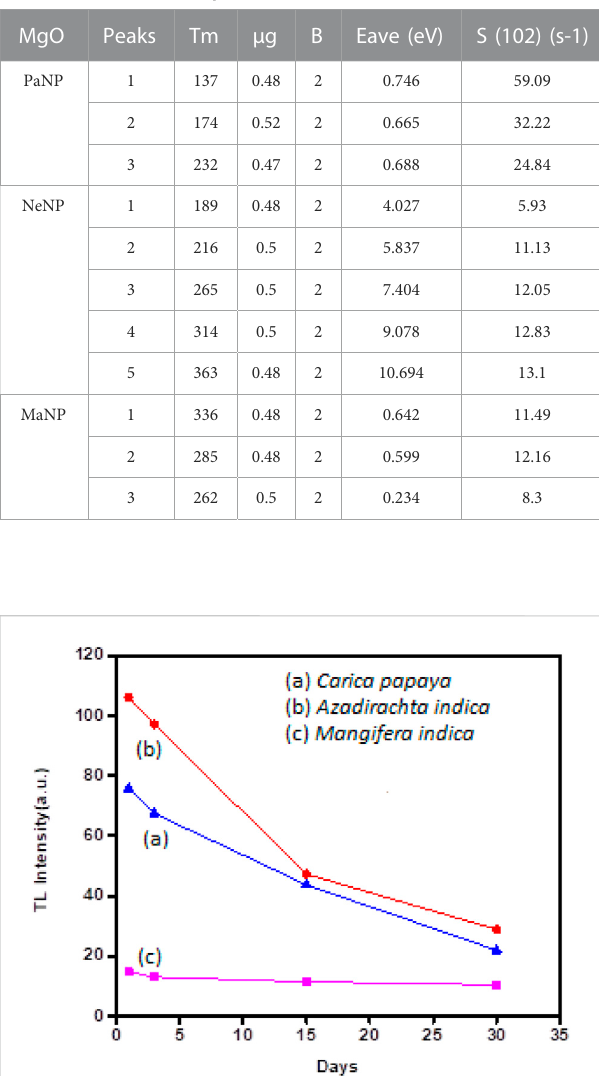
TABLE 3 Estimated kinetic parameters of Pa, Ne, and Ma nanostructures.